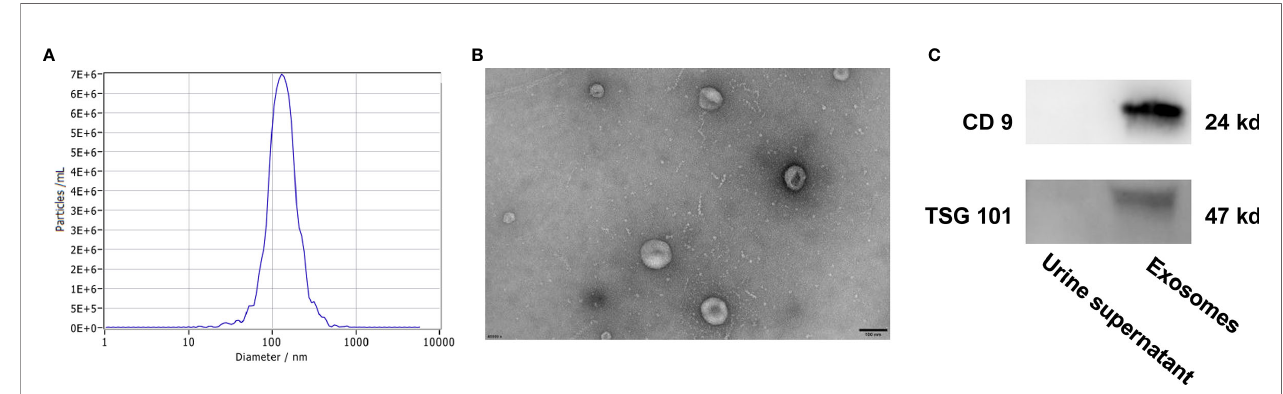
FIGURE 4 | Characterization of urine exosomes by Nanoparticle Tracking Analysis (A) , Transmission Electron Microscopy (B) , and western blot (C) .